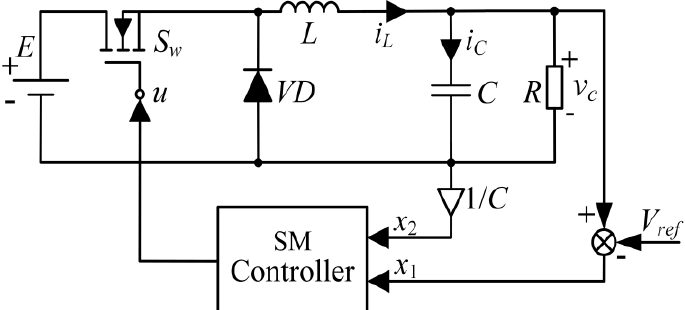
Figure 1. Structure diagram of SM controlled buck converters.